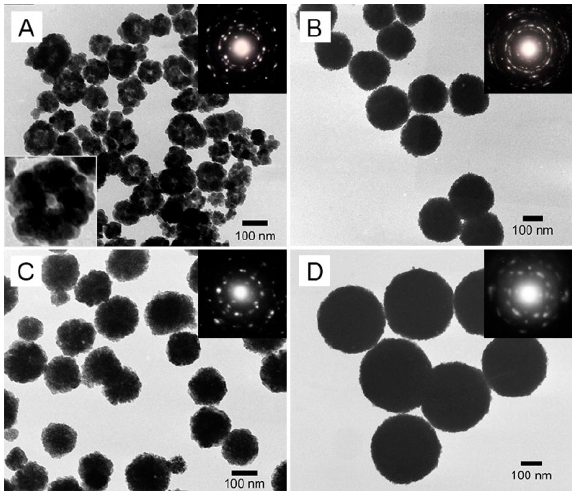
Figure 2. Transmission electron microscopy (TEM) images of ZnFe 2 O 4 CNAs: ( A ) CNA1; ( B ) CNA2; ( C ) CNA3; and ( D )